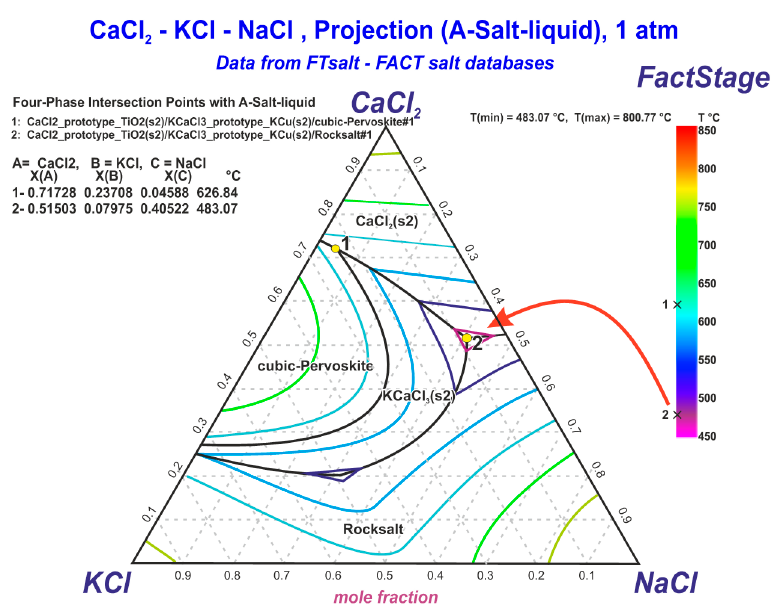
Figure 1. The ternary CaCl 2 -KCl-NaCl liquidus projection diagram by FactSage [26] with selected mole fractions of CaCl 2 , KCl and NaCl to provide the lowest eutectic melting point (483 °C).